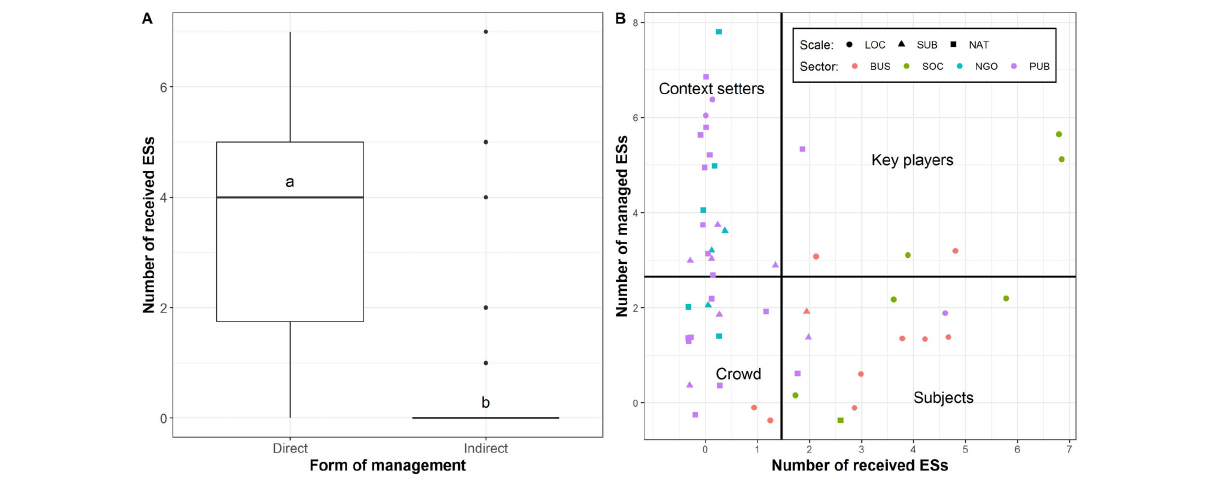
Fig. 6 . Differences in ecosystem service (ES) management and benefits. (A) Number of ESs benefiting stakeholders implementing direct and indirect management. Letters indicate significant differences (pairwise permutation tests, with alpha = 0.05). (B) Number of benefiting and managed ESs for each stakeholder. Jitter was added to improve the visualization of the two discrete variables and avoid overlap of points (factor = 2). Lines indicate mean values on both axes. BUS, business; LOC, local; NAT, national and international; NGO, nongovernmental organizations; PUB, public sector; SOC, civil society; SUB,